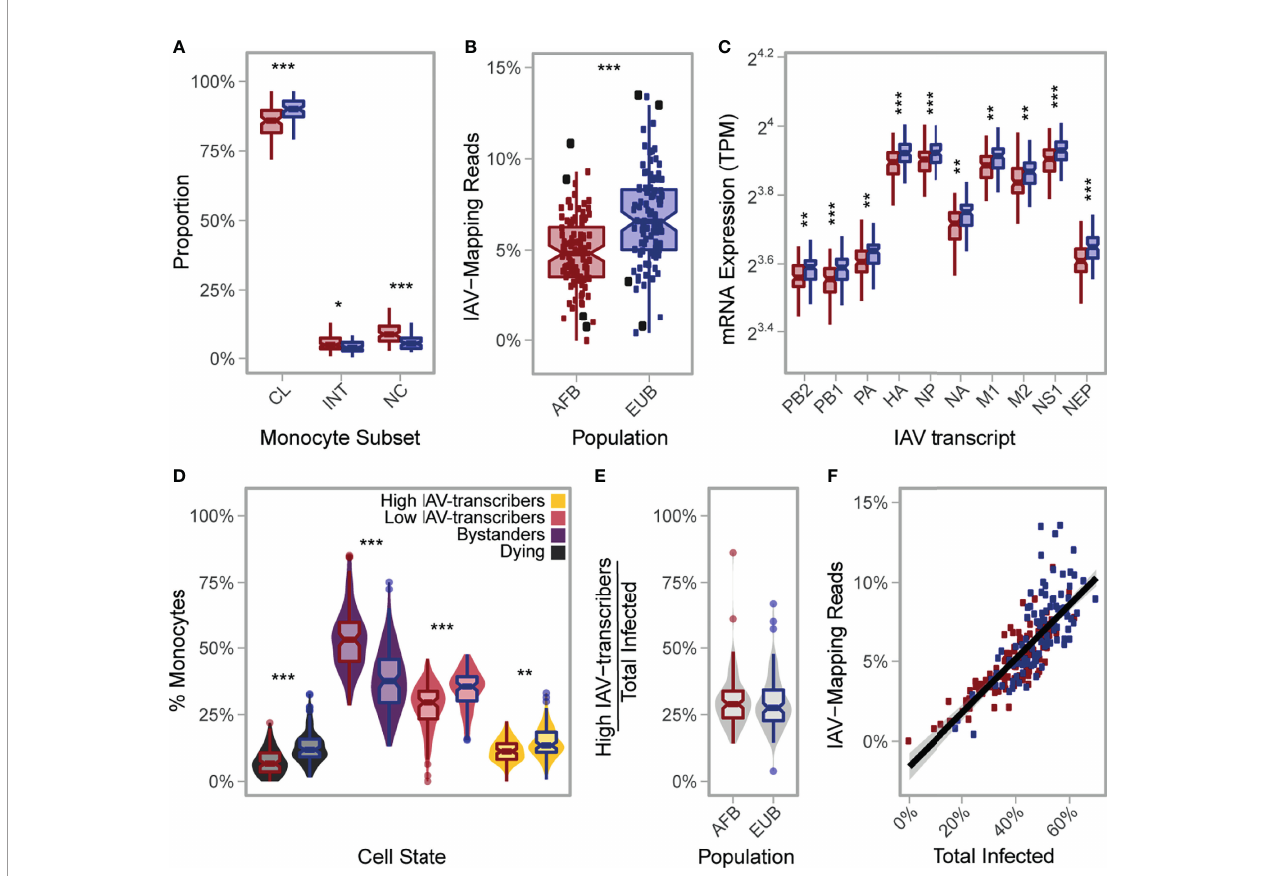
FIGURE 5 | African-ancestry individuals display increased number of CD16 + cells and lower susceptibility to IAV infection. (A) Variation in the number of classical (CD14 ++ CD16 - ), intermediate (CD14 ++ CD16 + ), and nonclassical (CD14 + CD16 ++ ) monocytes across African- and European- ancestry individuals following CD14 + selection from PBMCs ( n AFB = 89, n EUB = 85). Colors re fl ect population (AFB in red and EUB in blue). All three subsets are signi fi cantly different between populations ( p -value<0.01). (B) Inter- and intra-population variation in the percentage of RNA-seq reads mapping to the IAV genome ( n AFB = 100, n EUB = 99). Colors re fl ect population (AFB in red and EUB in blue). The percentage of RNA-seq reads mapping to the IAV genome is signi fi cantly higher in European-ancestry individuals relative to African-ancestry individuals ( p -value = 5.3×10 -8 ). Donors used in the scRNA-seq experiment ( n AFB = 4, n EUB = 4) are designated with enlarged black squares. (C) Inter- and intra-population variation in viral mRNA expression at 6hpi ( n AFB = 100, n EUB = 99). Expression levels for each of the 10 primary transcripts of IAV are plotted. Colors re fl ect population (AFB in red and EUB in blue). All IAV transcripts are signi fi cantly higher in European-ancestry individuals on average ( p - value<0.001). (D) Estimated distribution of the percentage of cells from each cell state in the bulk RNA-seq data ( n AFB = 100, n EUB = 99). Fill colors re fl ect cell state assignments, while outlines of boxplots re fl ect population (AFB in red and EUB in blue). (E) Distribution of the percentage of high IAV-transcribers among infected cells, strati fi ed by population. One individual with no infected cell was excluded ( n AFB = 99, n EUB = 99). (F) Percentage of RNA-seq reads of viral origin as a function of the estimated proportion of infected cells ( n AFB = 100, n EUB = 99), colored by population (AFB in red and EUB in blue). (A, C) Outlier points are not displayed. AFB, African-ancestry individuals from Belgium; EUB, European-ancestry individuals from Belgium; TPM, transcripts per million; IAV, in fl uenza A virus; MFI, mean fl uorescent intensity; CL, classical; INT, intermediate; NC, nonclassical. * p -value < 0.01; ** p -value < 0.001; *** p -value <